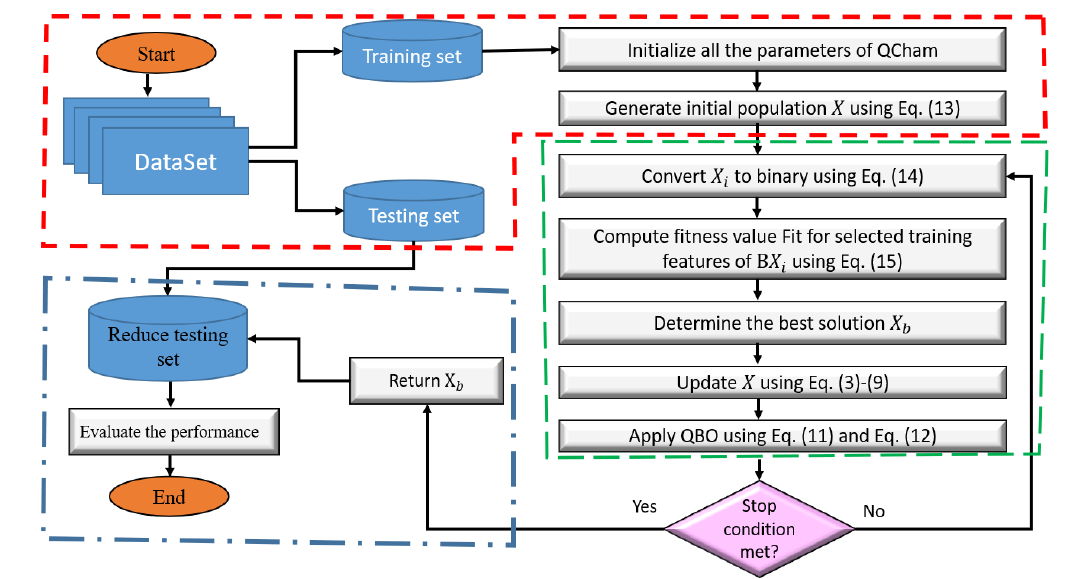
Figure 1. P rocedures of the QCham-based FS technique. Figure 1. Procedures of the QCham-based FS